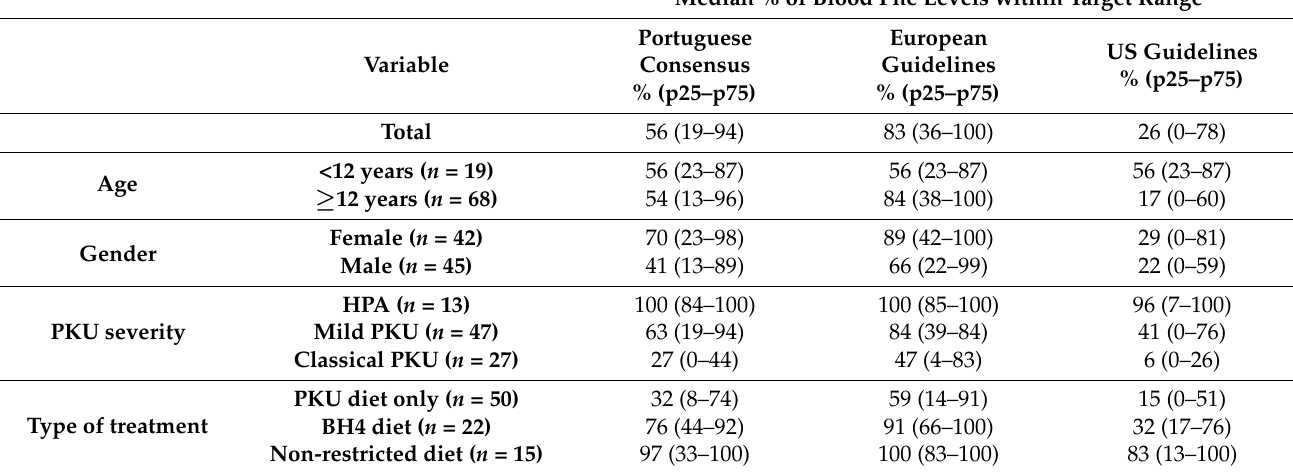
Table 4. Median percentage of blood Phe measurements within target range according to the Portuguese consensus, European and US